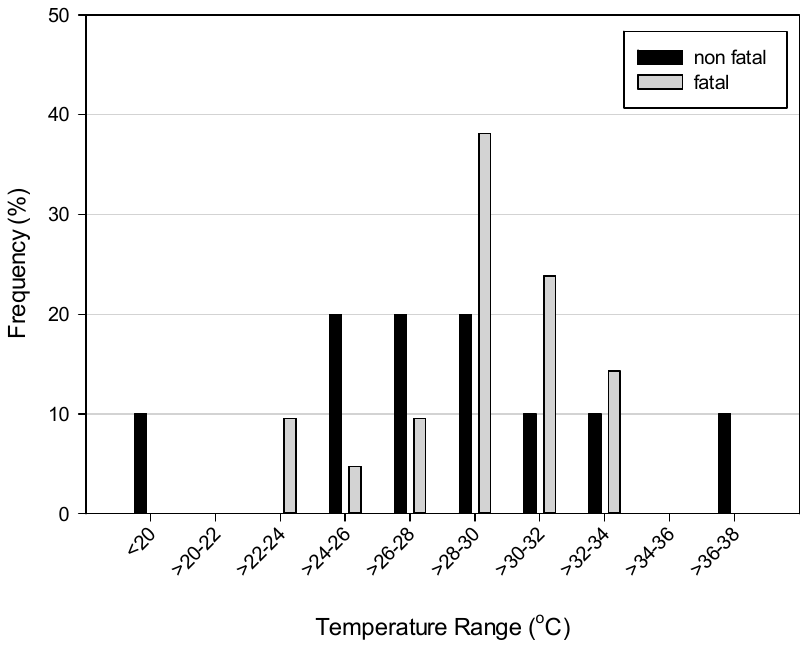
Figure 5. Histogram of maximum air temperatures for fatal and non-fatal incidents.